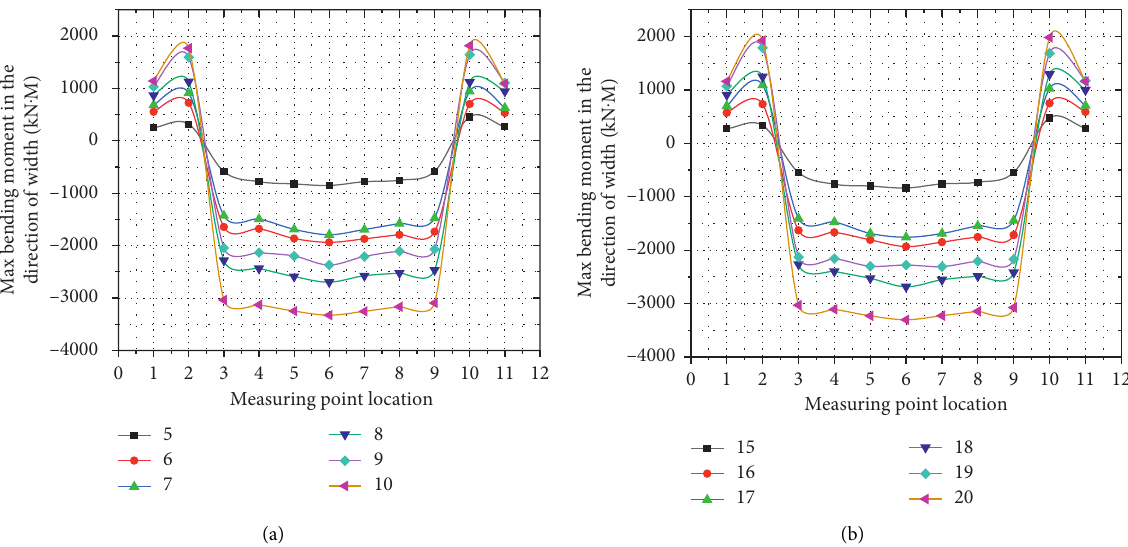
Figure 13: The maximum bending moment along the width of segments under various working conditions. (a) Three-tenon type segment. (b) Four-tenon type segment.